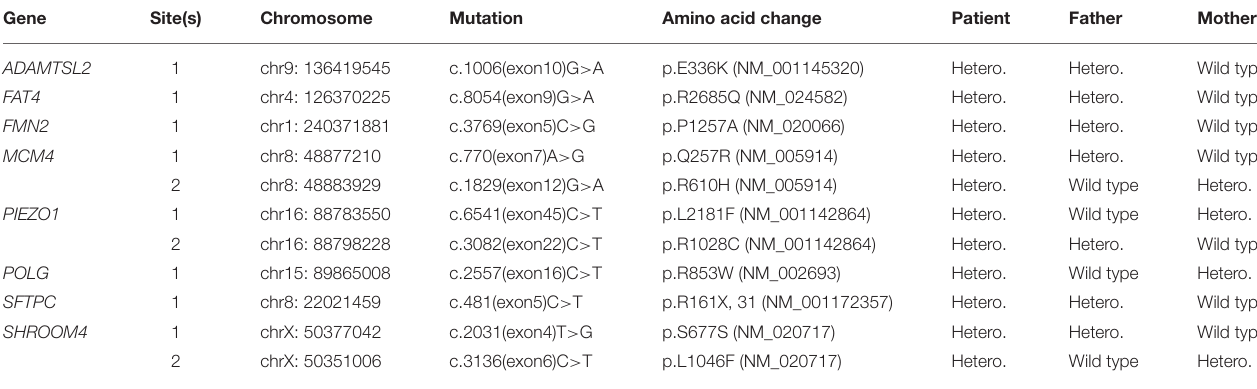
TABLE 2 | Identified missense mutations in proband and their status in her parents.